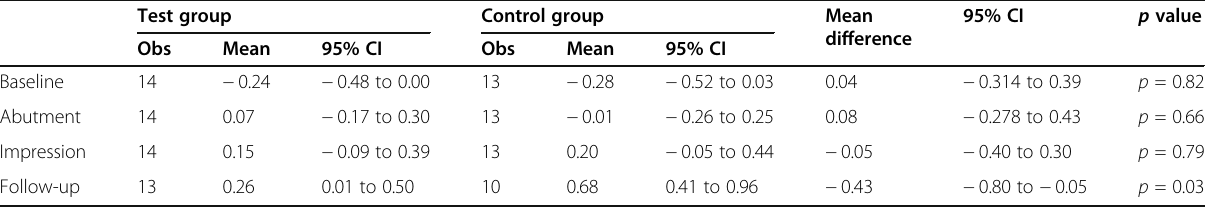
Table 2 Radiographic peri-implant marginal bone level in